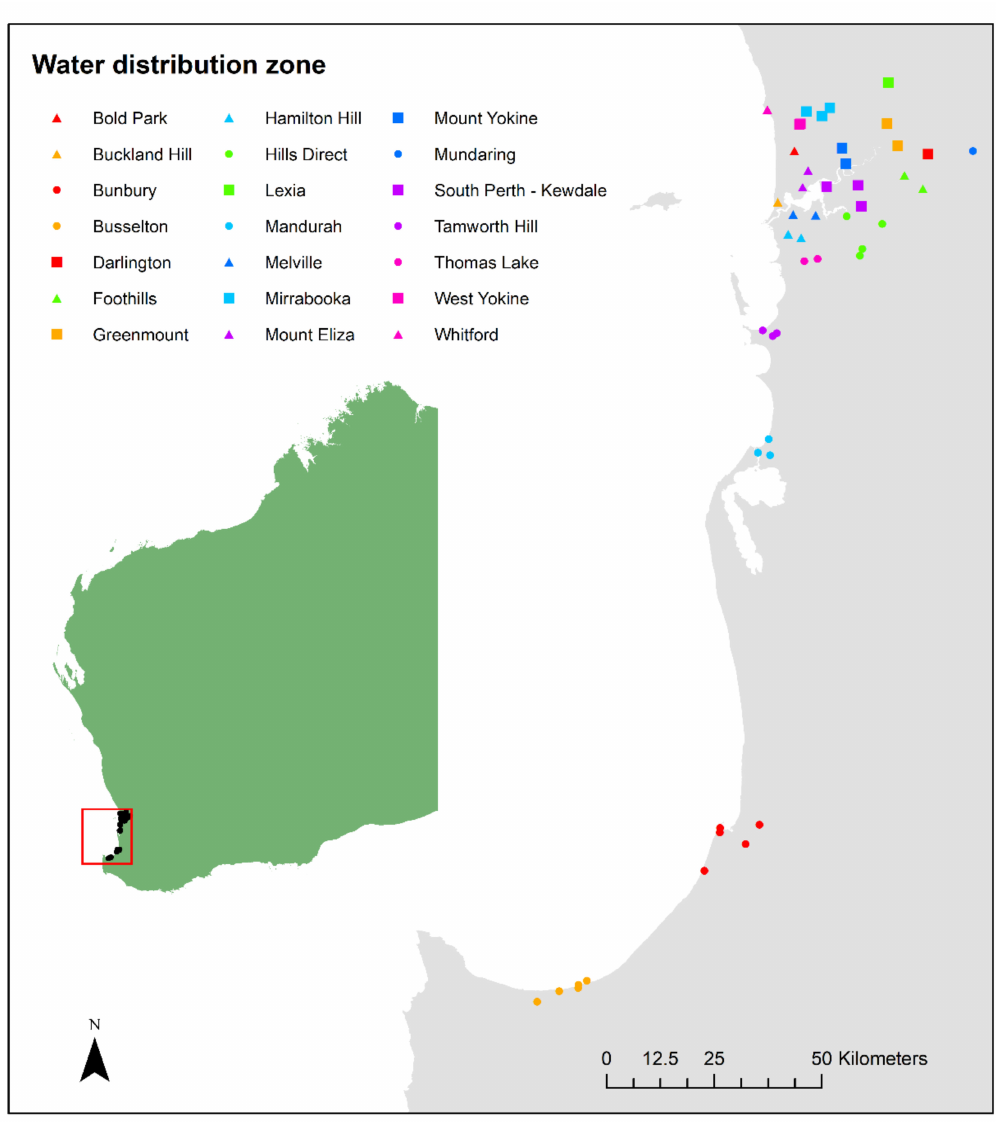
Figure 1. Map of the water sampling sites. Circles indicate sampling sites within water distribution zones (WDZs) with total trihalomethane (TTHM) concentrations in the lowest tertile, triangles indicate sampling sites within WDZs with TTHM concentrations in the middle tertile, and squares indicate WDZs with TTHM concentrations in the highest tertile. (Source: Jessica Stanhope, developed using ArcGIS 10 6 Arc